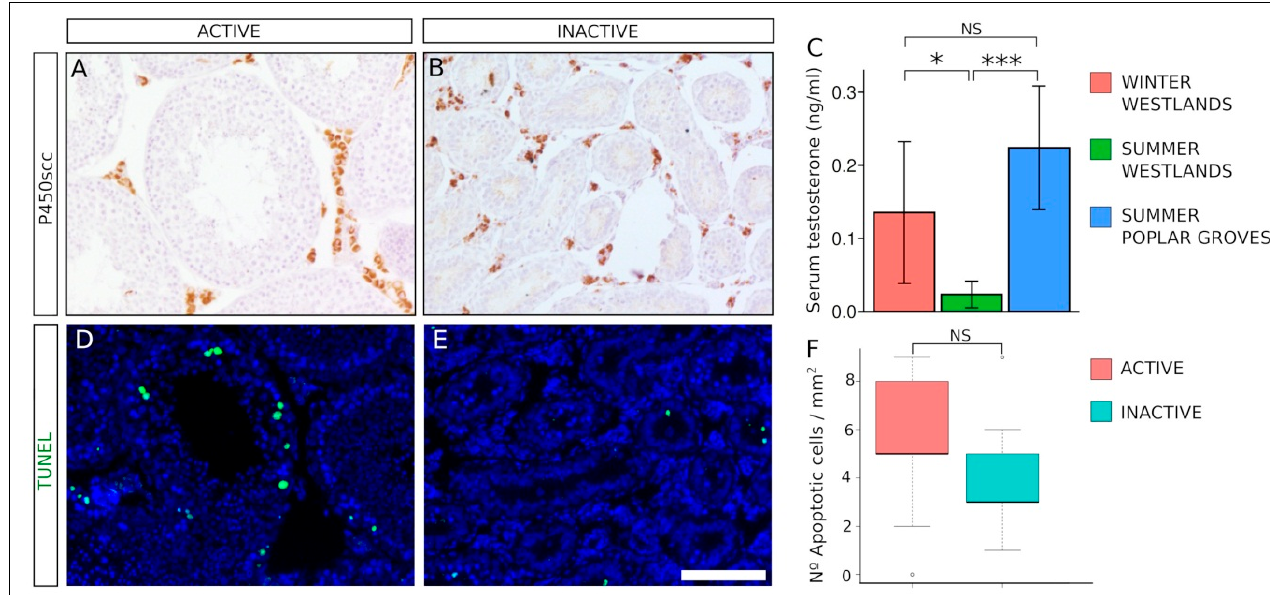
Figure 4. Reduced steroidogenesis but not increased apoptosis in regressed testes of M. duodecimcostatus ( A , B ). Immunohistochemistry for cholesterol side-chain cleavage enzyme (P450scc) in testis sections of voles captured in the wastelands showed a strong expression in Leydig cells with similar signal intensity during both winter ( A ) and summer ( B ). ( C ) Serum testosterone concentrations of male voles captured in different habitats and seasons. ( D , E ) TUNEL assay in testis sections of voles captured in the wastelands showed that in both winter ( D ) and summer ( E ) the number of apoptotic cells was very reduced. ( F ) Quantification of the number of apoptotic cells in winter and summer testes. Testes sections in ( D , E ) were counterstained with DAPI. Scale bar shown in ( D ) represents 100 μ m for all the pictures. NS, not significant; *, p < 0.05; ***, p < 0.001.